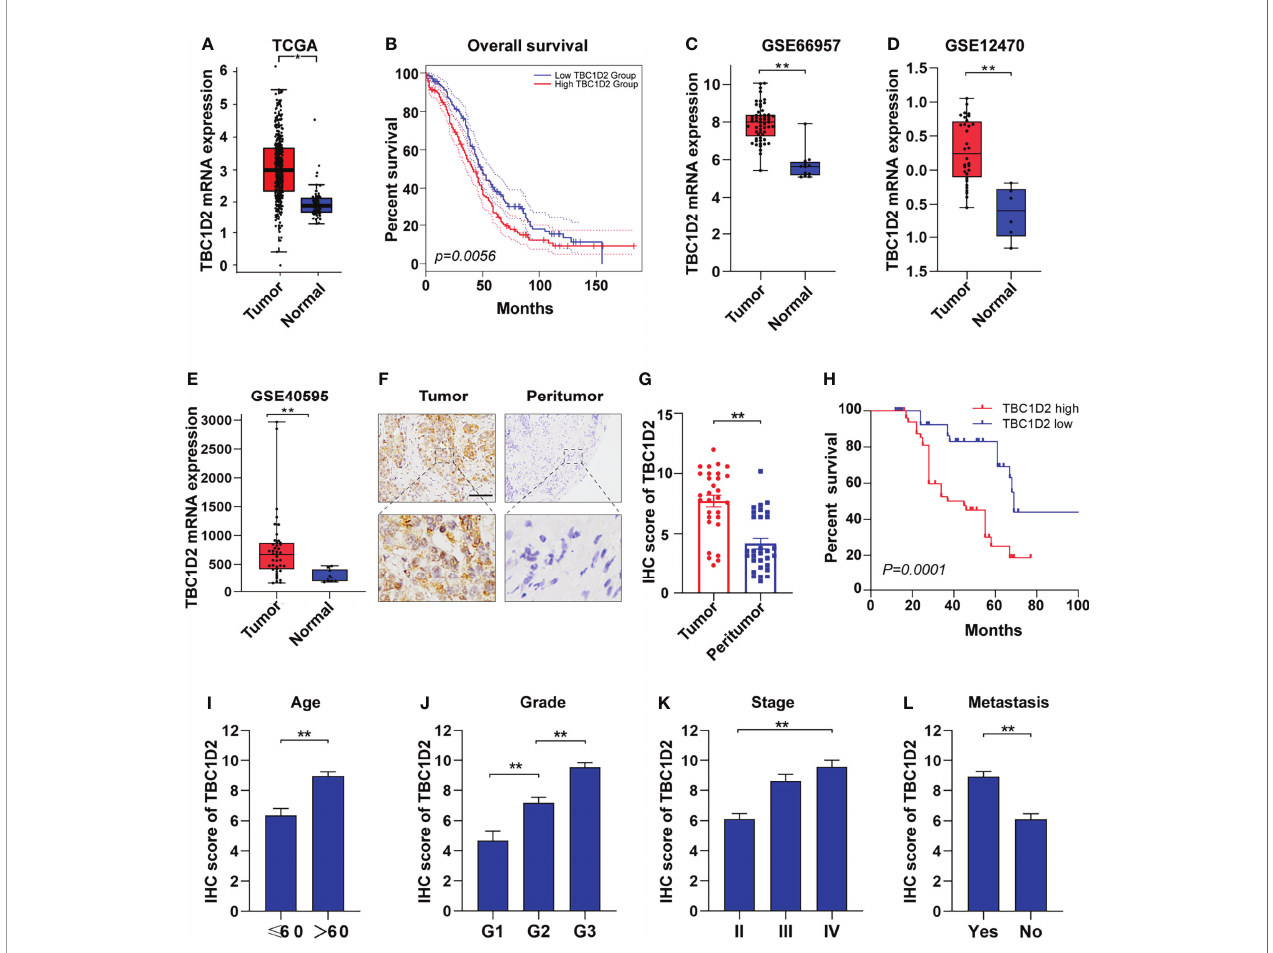
FIGURE 1 | TBC1D2 is upregulated in ovarian cancer and high expression level of TBC1D2 is associated with poor prognosis. (A) Expression of TBC1D2 in OC and normal tissues according to GEPIA 2 website. OC, ovarian cancer. (B) Overall survival rates of OC patients with high or low TBC1D2 expression level were evaluated by Kaplan – Meier plot and log-rank test according to GEPIA 2 website. (C – E) Expression of TBC1D2 in OC and normal tissues in GSE66957, GSE12470 and GSE40595 datasets. (F) Representative immunohistochemical staining images of TBC1D2 expression in human OC and peritumor tissues (n=100). bar, 100 m m. (G) IHC scores of TBC1D2 in OC tumor and peritumor tissues were evaluated in our cohort. (H) Overall survival rates of OC patients with high or low TBC1D2 expression level were evaluated by Kaplan – Meier plot and log-rank test. (I – L) IHC scores of TBC1D2 according to age, grade, stage and metastasis